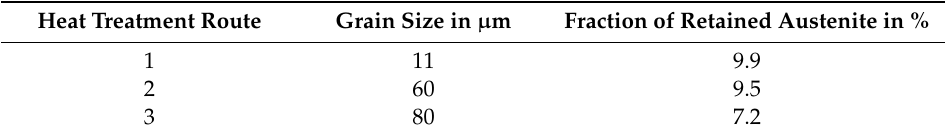
Table 2. Fraction of retained austenite concerning to the heat treatment